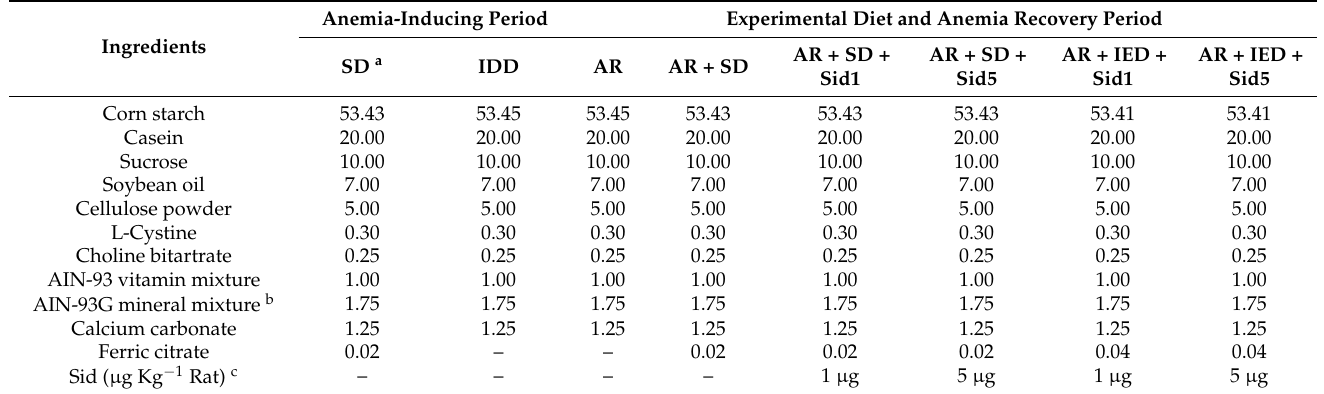
Table 1. Composition of the experimental diets used in iron-deficiency anemia induction and control (g 100 g − 1